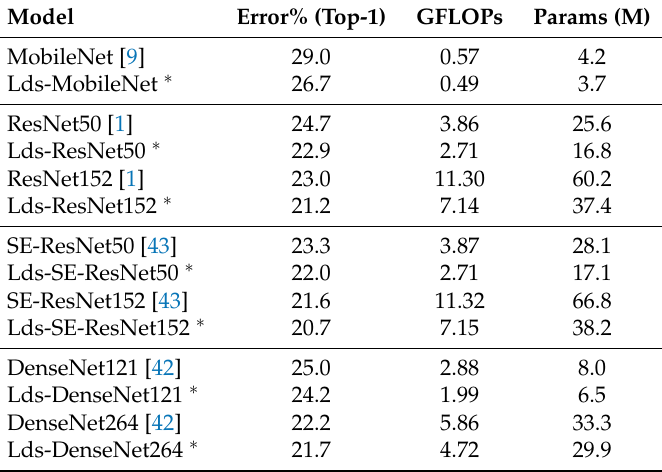
Table 3. The table shows the results for different models on ImageNet. ‘ ∗ ’ refers to the LdsConv using the balance loss. By simply replacing the standard 3 × 3 convolutional filters with our proposed LdsConv filters, we can not only improve the accuracy but also reduce the FLOPs and the number of parameters a lot. For the case of MobileNet, we highly increase the accuracy by 2.3% which is a pretty considerable